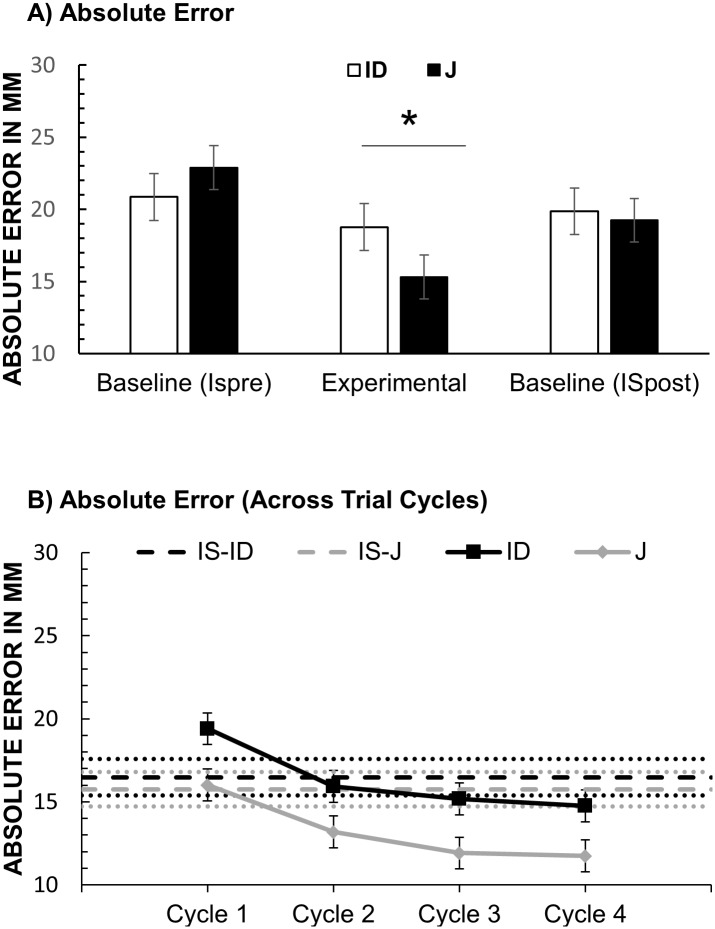
Results of Experiment 2.(A) Absolute error (mm) in the ID and J condition and in the corresponding ISpre and ISpost baselines. (B) Absolute error across consecutive trial cycles in the ID and J conditions. Error-bars stand for within-subject 95% CIs from the Condition × Cycle ANOVA (see main text).